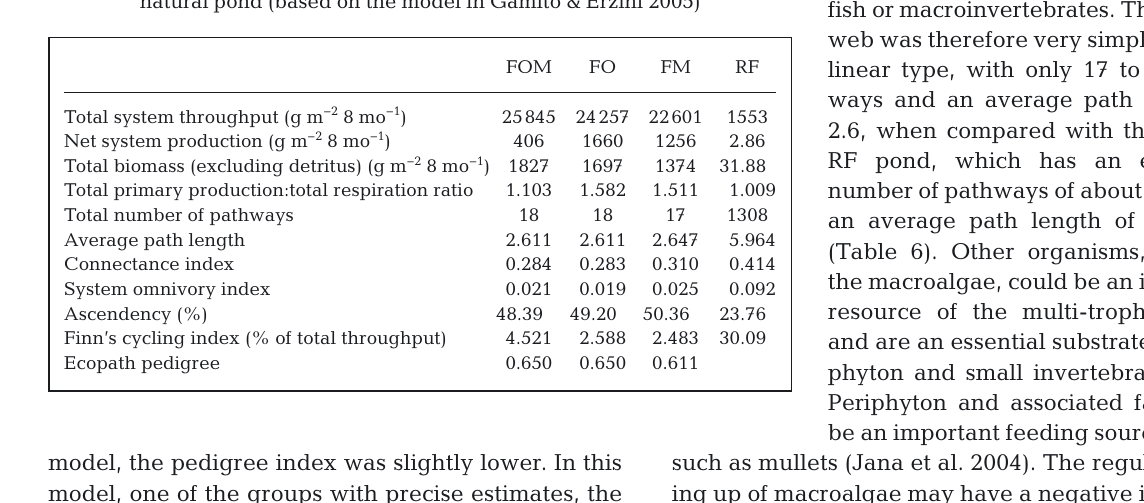
Table 6. Summary statistics for the 4 Ecopath models. FOM: fish, oysters and macroalgae; FO: fish and oysters; FM: fish and macroalgae; RF: Ria Formosa natural pond (based on the model in Gamito & Erzini